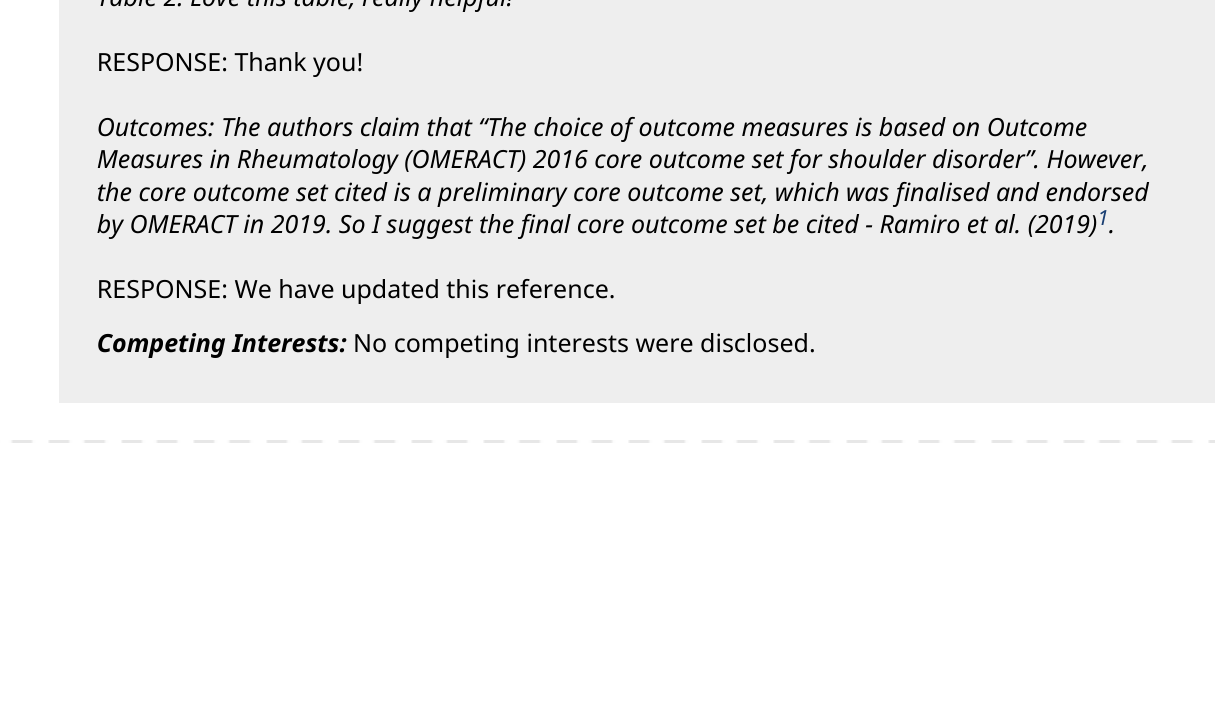
Figure 1: It might help to clarify that the second injections will be delivered 2-3 weeks after the first injection. It would also help to specify if follow-up is at 3-months from randomisation, or 3- months after receiving the second